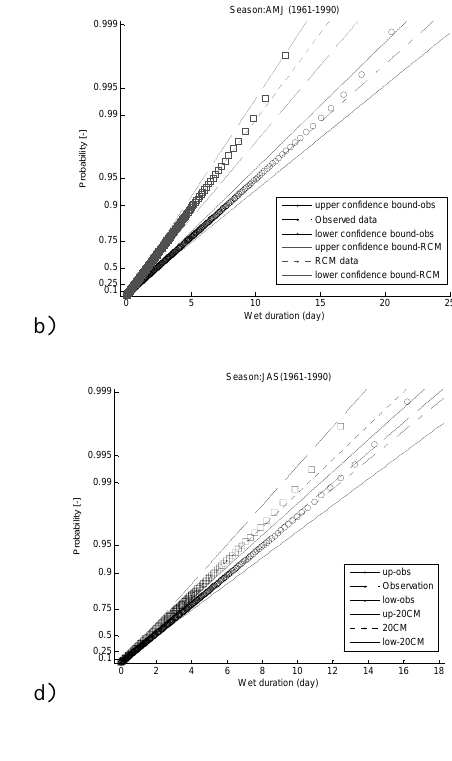
Figure 5. Same as Figure 4, but for spring (AMJ) and summer (AMJ). Fig. 5. Same as Fig. 4, but for spring (AMJ) and summer